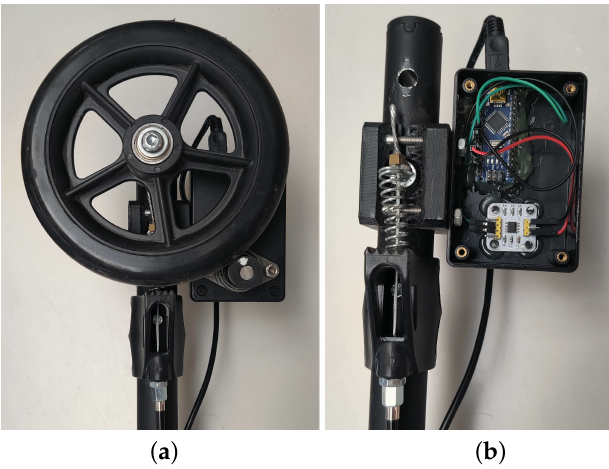
Figure 5. Encoder sensor: ( a ) encoder-wheel detail, ( b ) arduino encoder